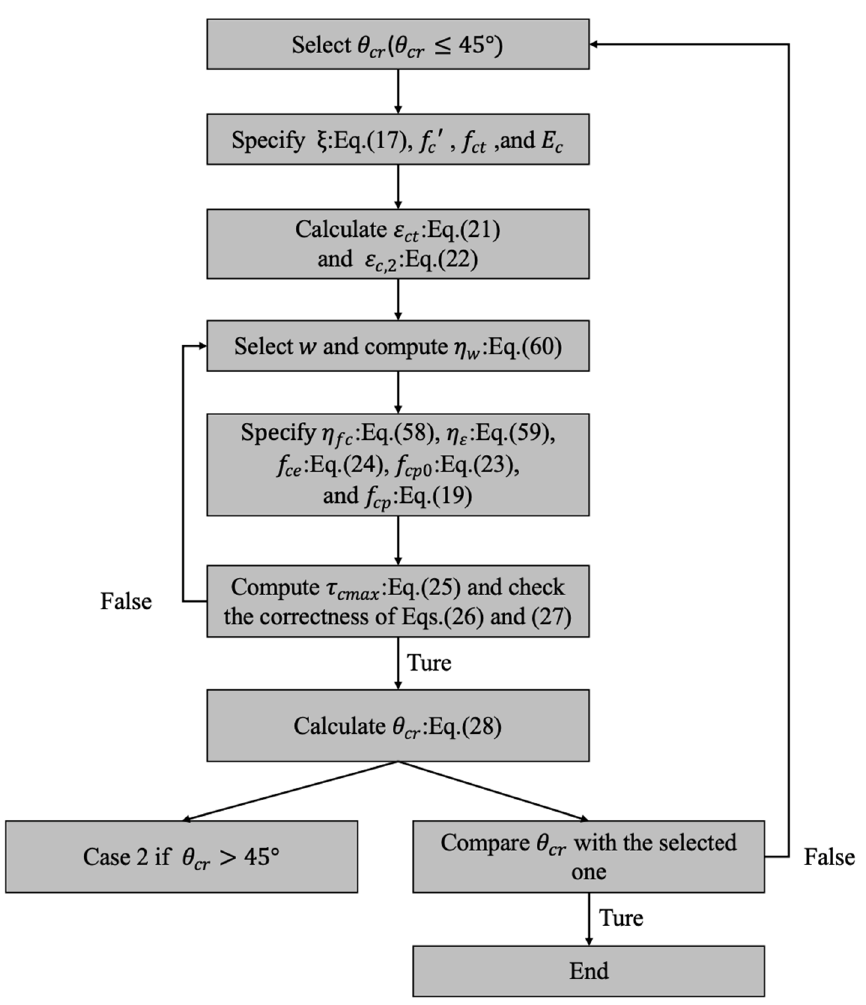
Figure 14. Analysis flowchart to estimate cracking angle 𝜃 (cid:3030)(cid:3045)